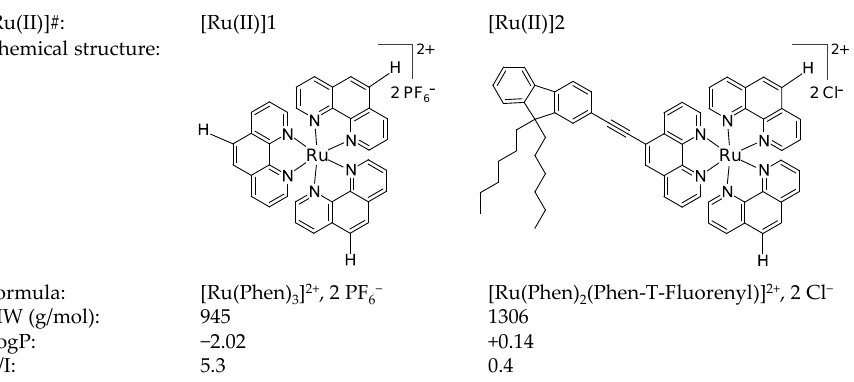
Figure 1. Chemical structure and relevant features of [Ru(II)] used in this study. The partitioning index LogP is a measure of the difference in solubility of the compound in 1-butanol and in water. I 0 /I is a measure of the singlet oxygen production efficiency, as determined using a Stern–Volmer analysis. LogP and I 0 /I were calculated and reported in our previous study (in which the counter-ion was hexafluorophosphate for both compounds) [23]. “Phen”: 1,10 -phenanthroline.